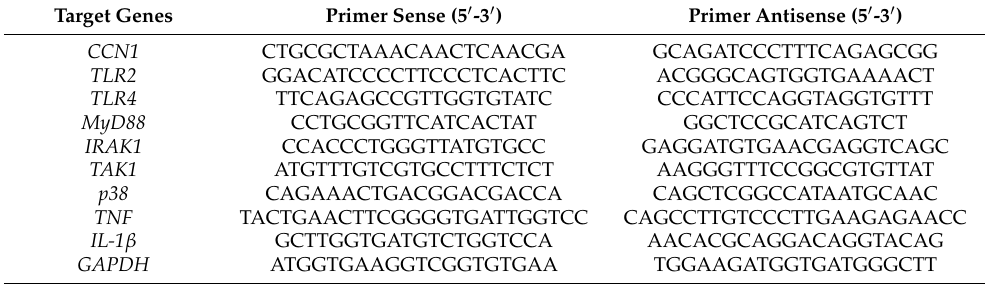
Table 1. Primer sequences used for